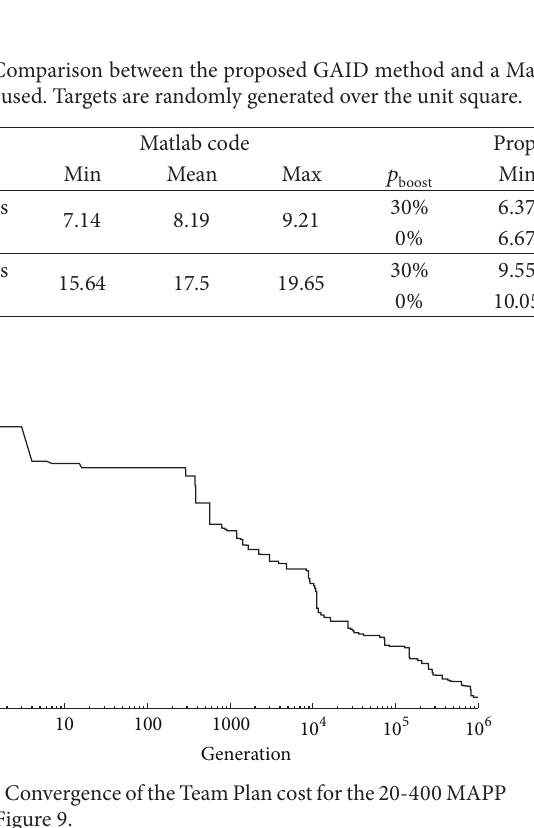
Figure 9: The GAID algorithm was performed on a MAPP with 20 agents and 400 targets located in the unit square. The Team Plan cost was 1.91 after the initialization and was reduced to 1.08 by the end of the 150000 th generation and to 0.94 by the end of the simulation. The longest subtour is highlighted by a thick line.